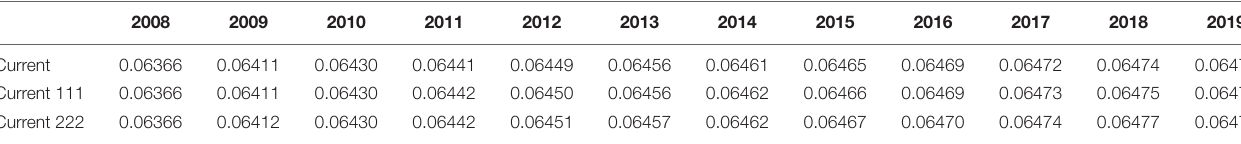
FIGURE 13 | Impact of the macro government investment in science and technology innovation on operating revenue. TABLE 6 | Influence of the macro government investment in science and technology innovation on network collaborative manufacturing